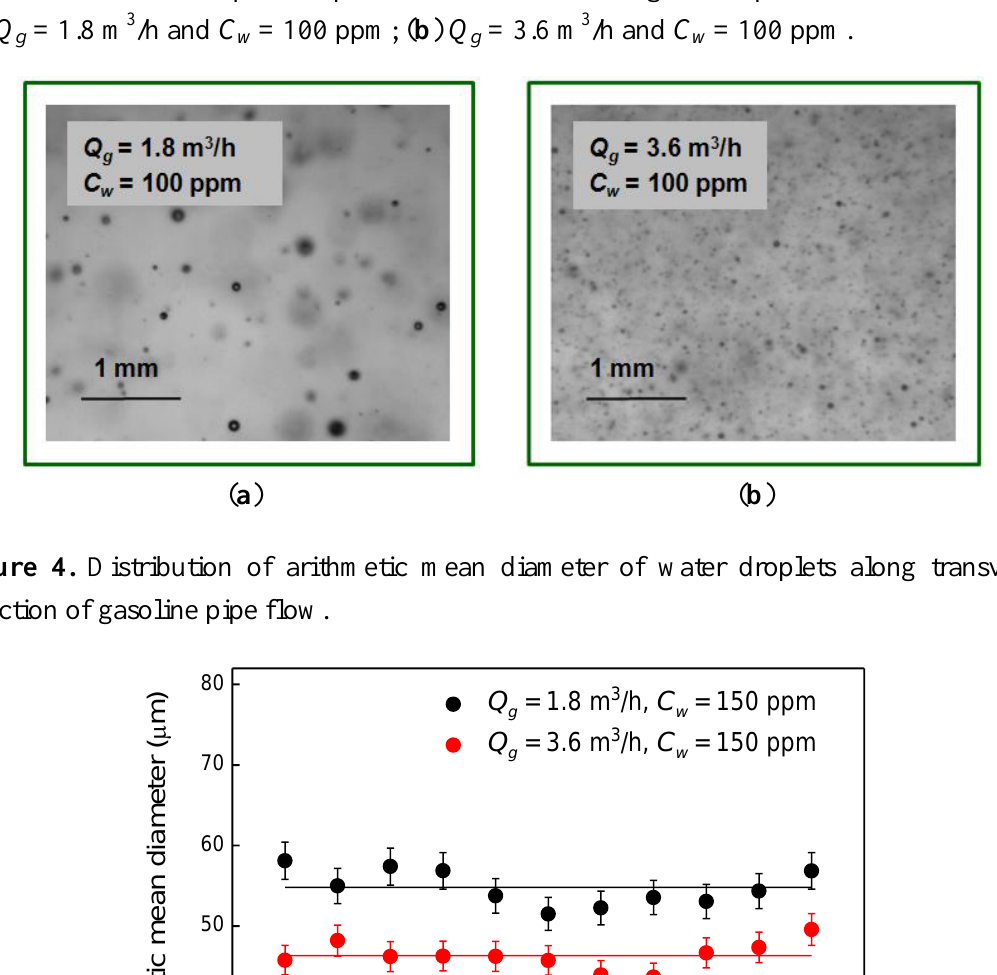
Figure 3. Water droplet dispersion visualized through transparent test window 2: